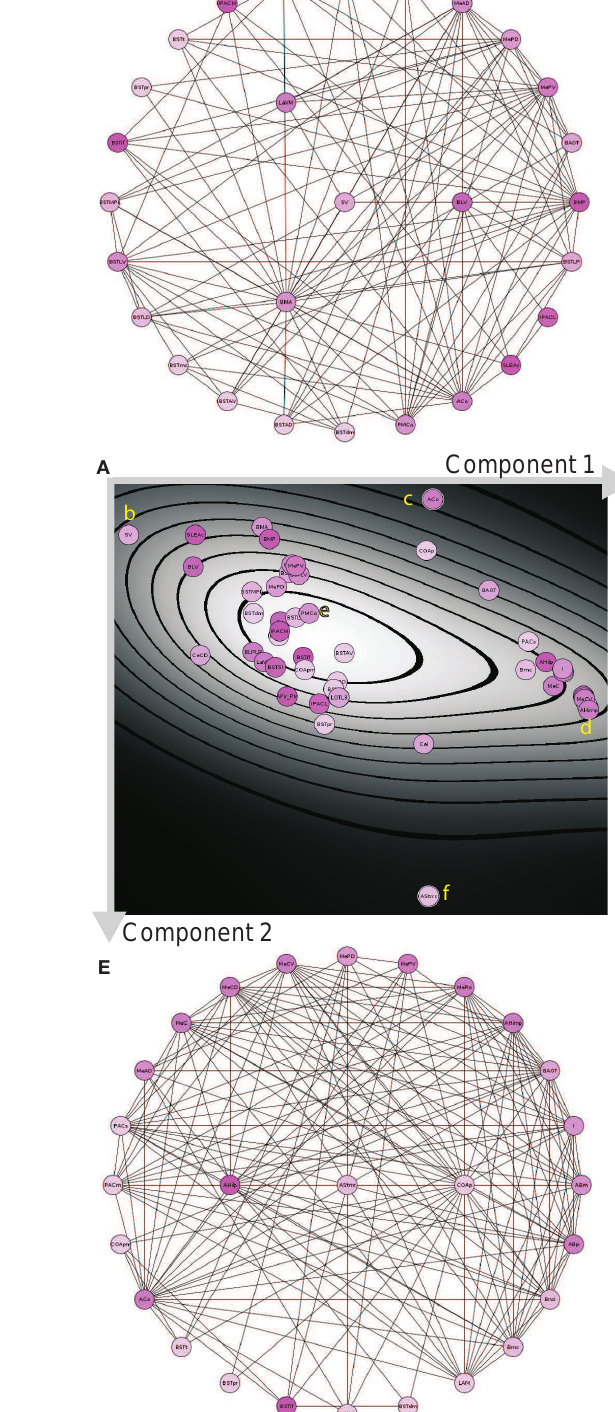
FIGURE 9 | PCA analysis of the condensed intrinsic amygdala network. (A) Probability density diagram of the 2-dimensional plane of PCA showing the 49 mapped regions. Component axes are indicated and correspond to Table 5 .Yellow letters refer to the circle-diagrams. All circle-diagrams have a center circle that correspond to a region of interest of the PCA-plane in (A) .